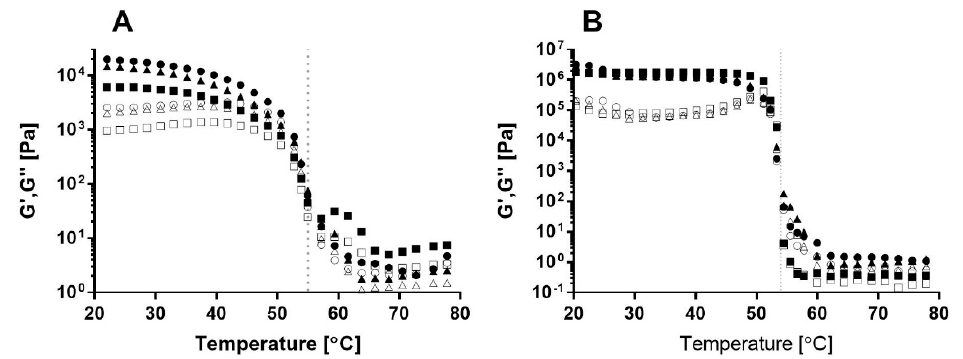
Figure 1. Typical temperature sweep moduli curves obtained for ( A ) bigel and ( B ) oleogel produced with SE HLB1 ( ● , о ), HLB2 ( ▲ , ∆ ), and HLB6 ( ■ , □ ) at 5 °C min − 1 cooling rate. Storage modulus (G’, closed symbols) and loss modulus (G”, open symbols). Oleogel samples consist of 25 wt % GMS, 1.6 wt % lecithin, and 2 wt % SE.